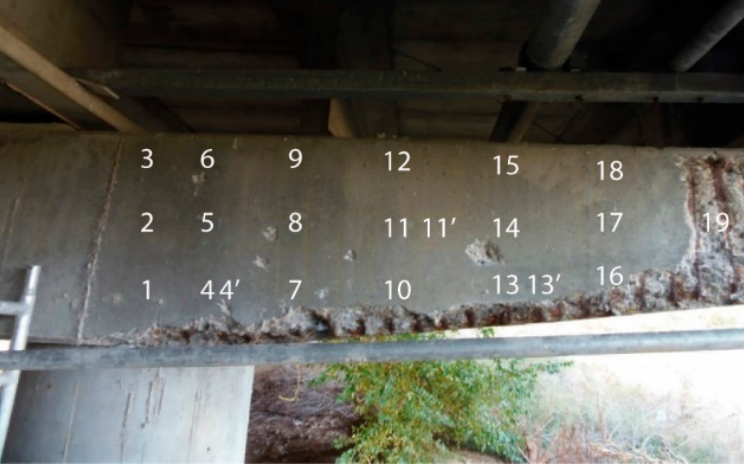
Figure 4. Points measured on the surface of the girder analysed (photo taken by S.